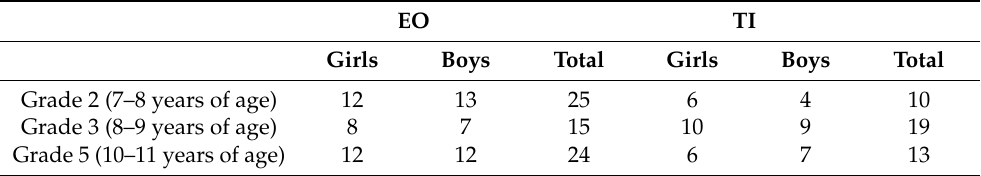
Table 1. Number of children belonging to experimental outdoor intervention (EO) and traditional indoor intervention (TI). EO TI Girls Boys Total Girls Boys